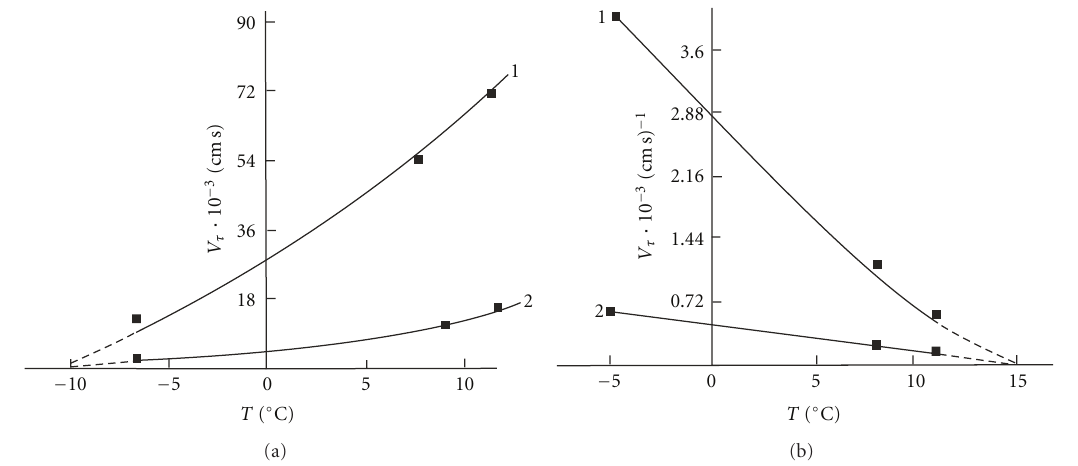
Figure 3: Estimation of the boundary temperatures of phase separation for the CTA-nitromethane system with a polymer concentration of 2wt% by extrapolation of the direct (a) and inverse rates (b) of turbidity growth, calculated at the stage of intense τ changes (1, method 1) and from the initial fragment of the kinetic τ = f ( t ) curve (2, method 2).